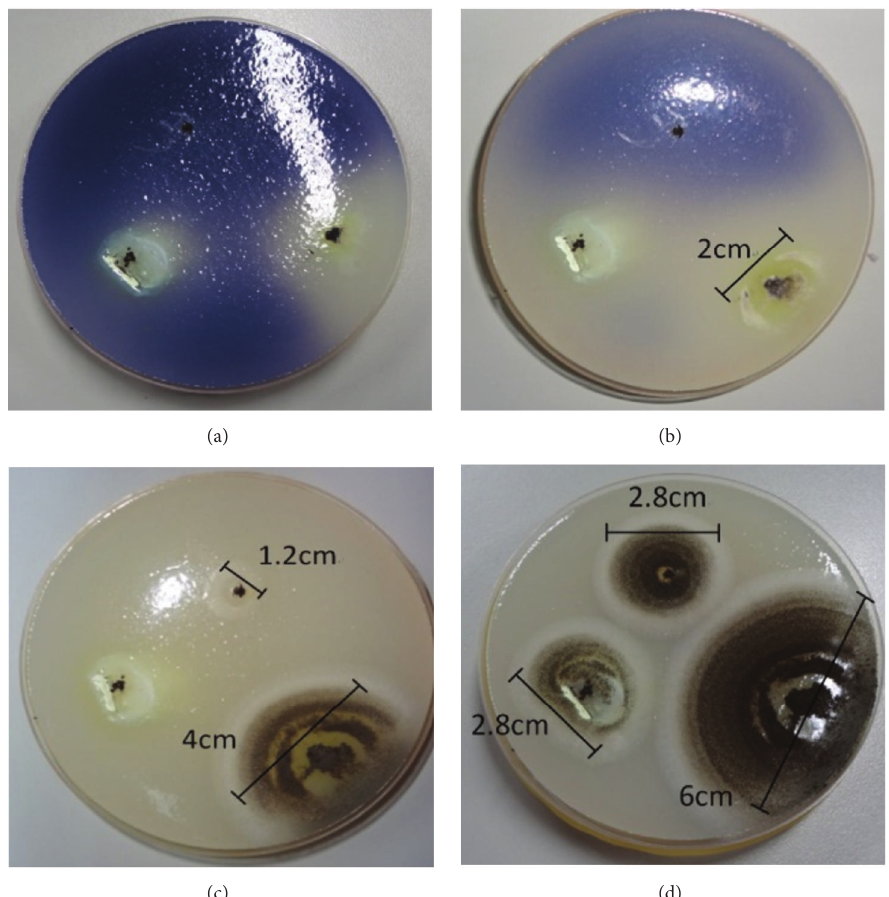
Figure 6: Silver iodide from conductance for the first time of (a) placement of molds, (b) 3 days after placement of molds, (c) 6 days after placement of molds, and (d) 10 days after placement of